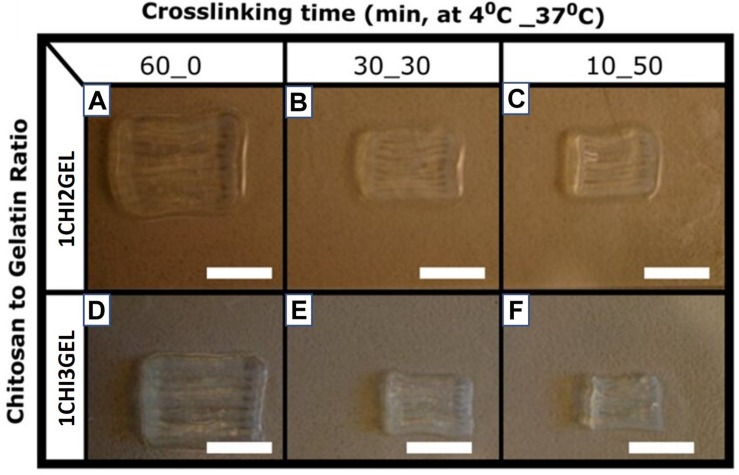
Printed structure obtained for each ratio (1CHI2GEL on the top, and 1CHI3GEL on the bottom) and for each crosslinking condition performed, respectively, 60_0, 30_30, and 10_50. Scale bar: 5 mm. From a qualitative point of view, (A,D) 60_0 crosslinking condition shows the best results in terms of shape integrity, while (B,E) 30_30 and (C,F) 10_50 lose the structural integrity.